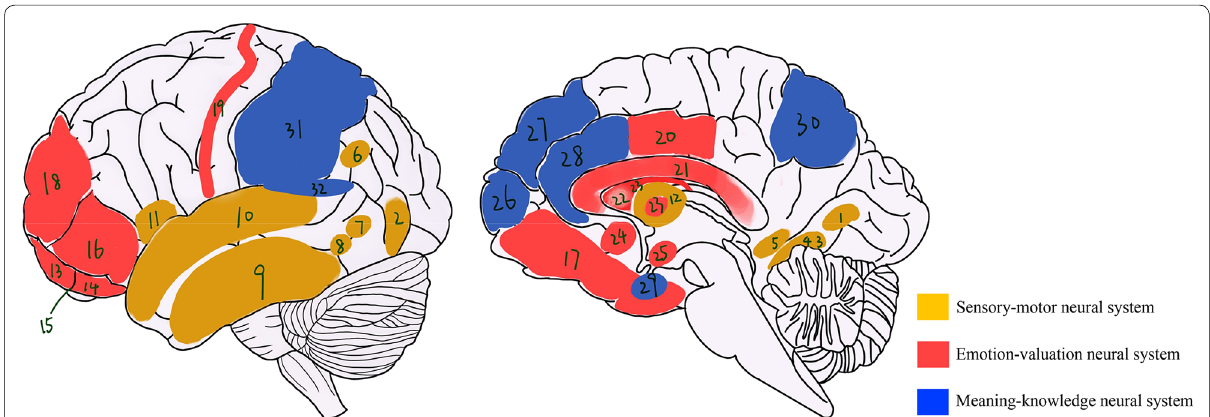
Fig. 2 Brain regions from three neural systems. Sensory–motor neural system includes brain regions marked with yellow color: 1. lingual gyrus, 2. middle occipital gyrus, 3. fusiform face area, 4. fusiform gyrus, 5. parahippocampal gyrus, 6. bilateral angular gyrus, 7. visual motion area, 8. extrastriate body area, 9. inferior temporal cortex, 10. superior temporal gyrus, 11. anterior insula bilaterally, and 12. putamen. Emotion–valuation neural system includes brain regions marked with red color: 13. medial OFC, 14. lateral OFC, 15. OFC, 16. VLPFC, 17. VMPFC, 18. DLPFC, 19. fronto-temporal junction, 20. Posterior cingulate cortex, 21. caudate nucleus, 22. ventral striatum, 23. striatum, 24. nucleus accumbens, and 25. amygdala. Meaning-knowledge neural system includes brain regions marked with blue color: 26. Brodmann areas 9/10, 27. dorso-medial prefrontal cortex, 28. bilateral anterior cingulate cortex, 29. temporal pole and entorhinal cortex, 30. precuneus, 31. superior and inferior parietal cortex, and 32. temporoparietal